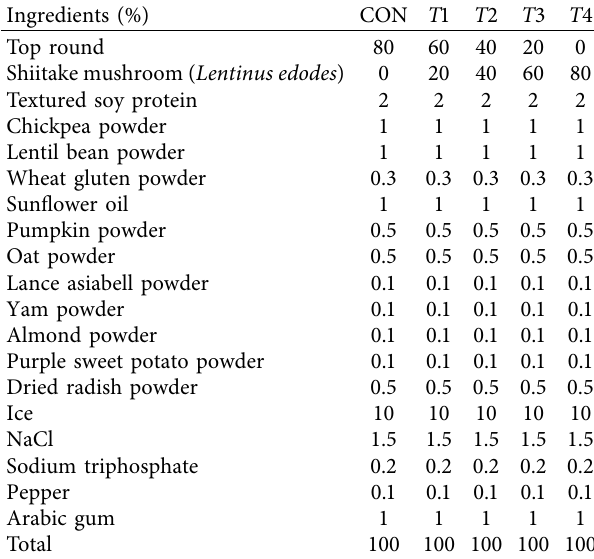
Table 1: Te formulations of a hybrid beef patty with shiitake mushroom ( Lentinus edodes